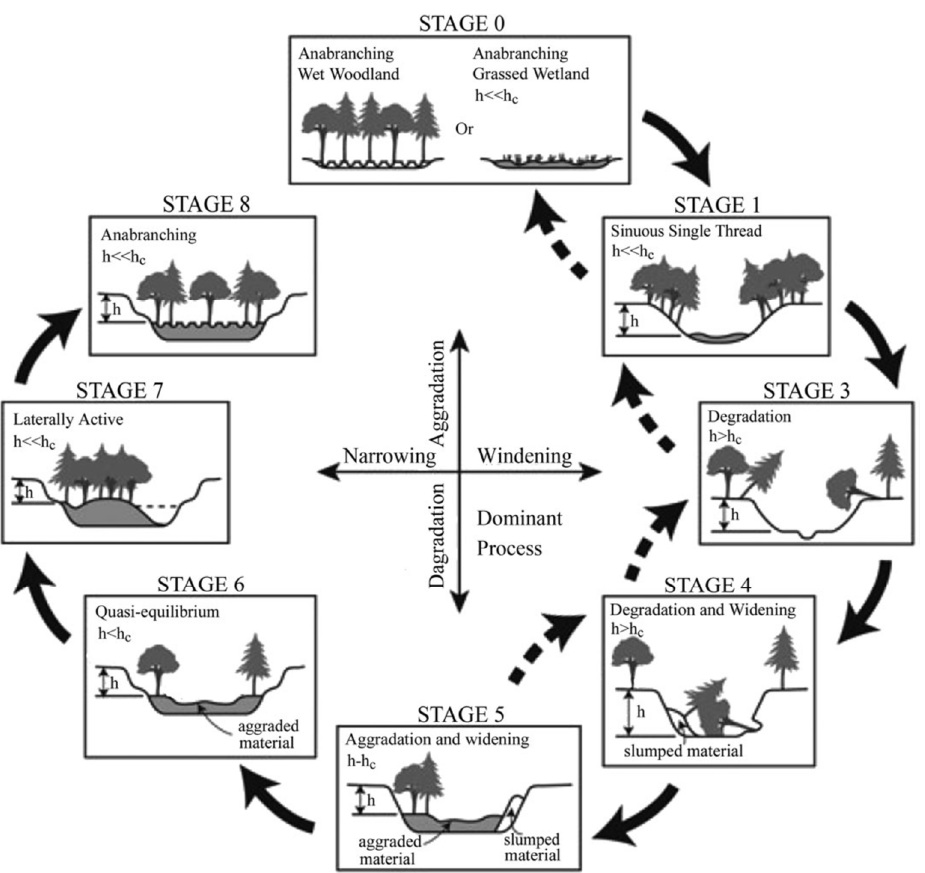
Figure 1. Developed model for channel adjustment, affected by massive sediment input in the North Toutle River (NFTR) [8] (h is the bank height, and hc is the critical stability bank height). Stage 2 in the original SEM is omitted as it is not relevant to the evolution of the upper NFTR. ‘Anabranching’ is used instead of ‘anastomosing’ in stages 0 and 8 to better reflect the conditions in the NFTR. Reprinted with permission from ref. [8]. Copyright 2021 John Wiley &